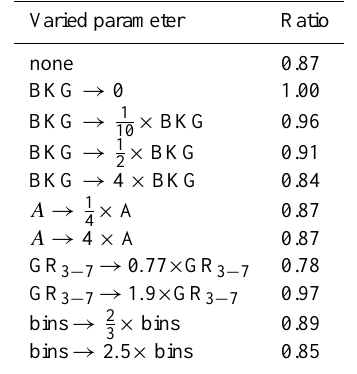
Table 2. Sensitivity of the ratio of formation rates (Eq. (3)/Eq. (5), calculated as a mean of values during 11:00–13:00) to modifications and improvements in analysis. The first three improvements are included in all the latter ones (applied at the respective size